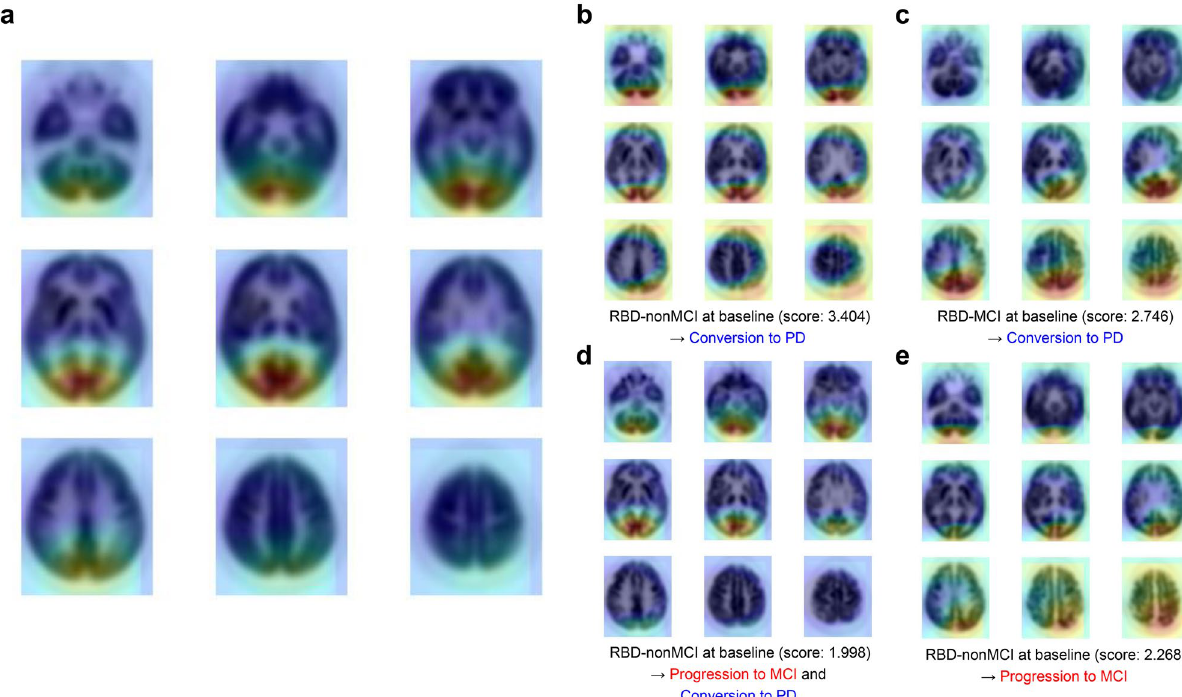
Figure 3. Cognitive dysfunction-related region mapping. ( a ) The averaged CAM of iRBD patients with a higher DL-based cognitive dysfunction score than the optimal cutoff value (− 1.930). Cognitive dysfunction- related regions mainly included posterior cortical regions. ( b - e ) Representative CAM of individuals who ( b - d ) converted to overt neurodegenerative disease or ( d , e ) progressed to MCI. The number in parentheses is DL-based cognitive dysfunction score of